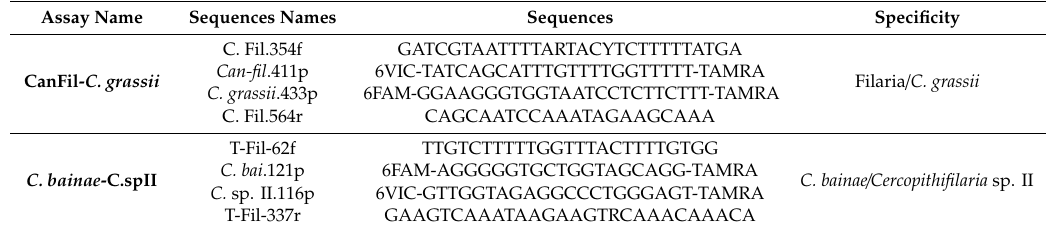
Table 1. Primers and Probes Designed for Duplex qPCR Assays accordingly to Species